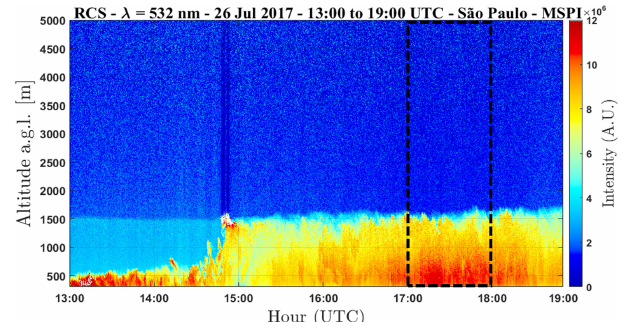
Figure 2. Time–height plot of RCS 532